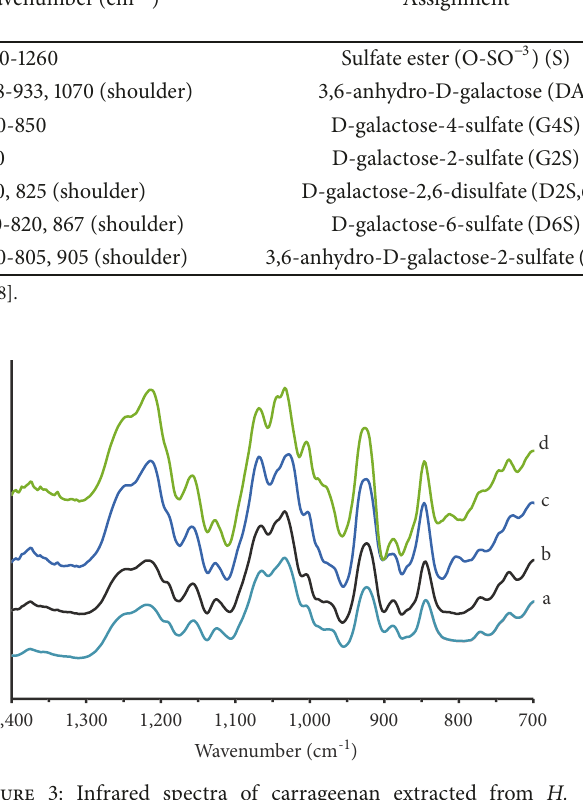
3,6-anhydro- D-galactose-2-sulfate [11, 31, 37] were absent. The 805 cm −1 band is characteristic and distinctive of i - carrageenan [43] (Figure